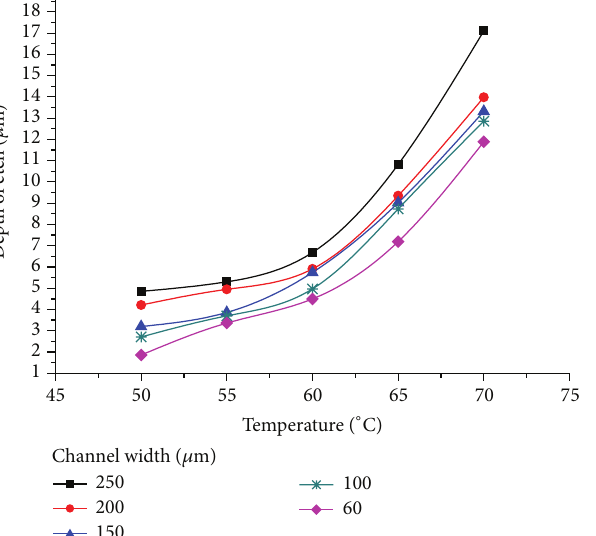
Figure 7: Effect of temperature on depth of etch for different chan- nel